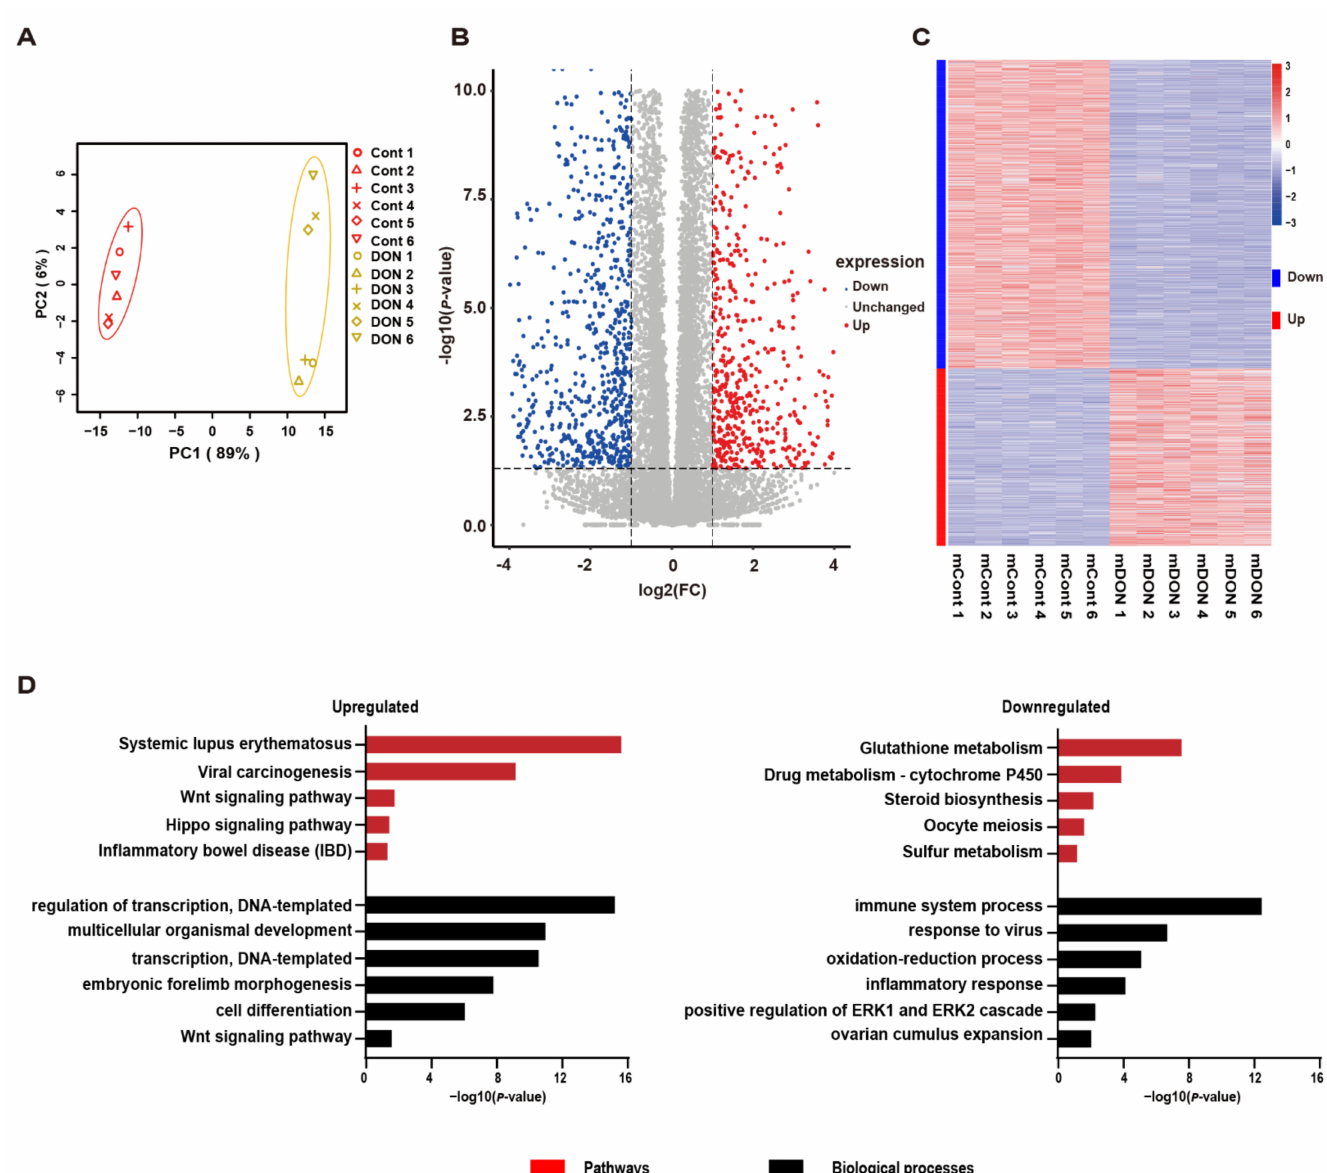
Figure 3. The analysis of differentially expressed genes between the DON-treated and control groups. ( A ) The principal components analysis (PCA) plot of RNA-seq samples. ( B ) Volcano plot of differential expression profiles between the DON-treated and control groups. ( C ) Heatmap of differential expression profiles between the DON-treated and control groups. ( D ) The top enriched pathway and GO terms for the differentially expressed genes. The rich factor is defined as the ratio of the number of differentially expressed genes enriched in the pathway to the number of annotated